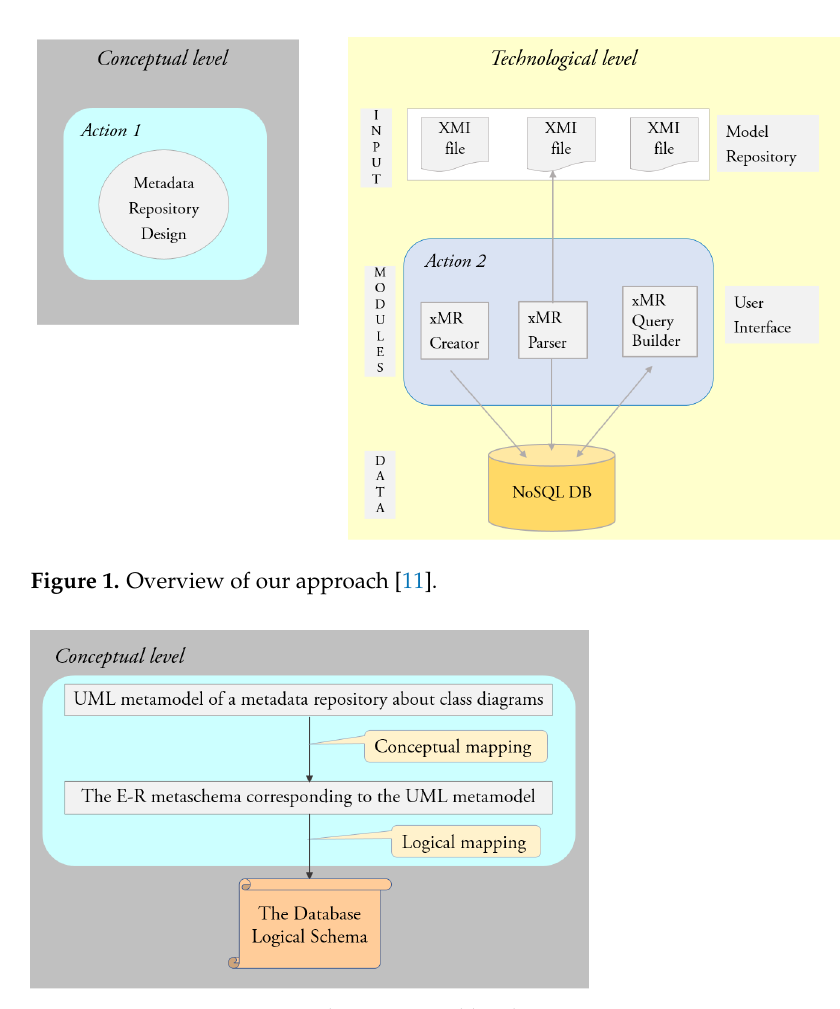
Figure 2. Design activities at the conceptual